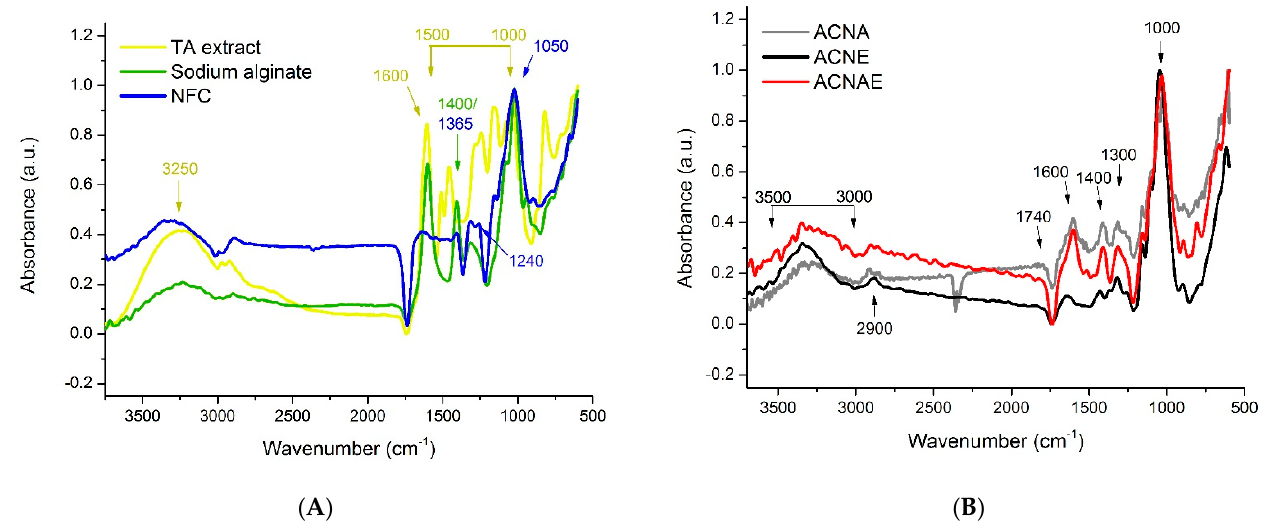
Figure 2. Infrared spectra of the bio-based compounds ( A ) and NFC-based hydrogels ( B ).